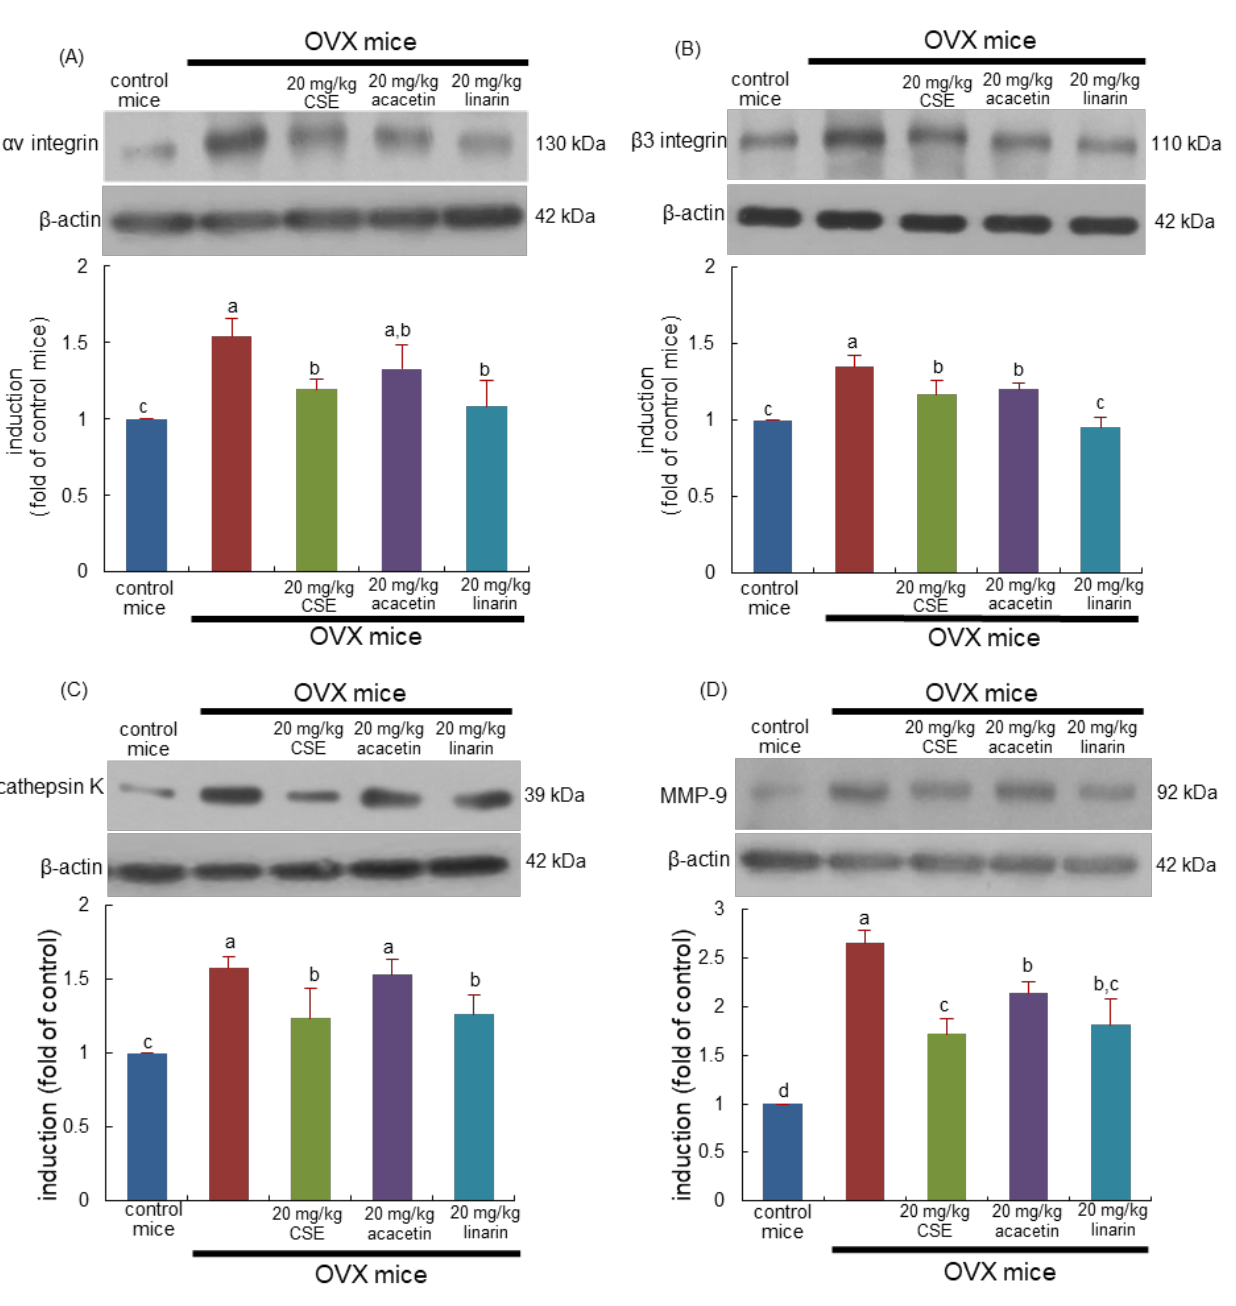
Figure 4. Blockade of induction of α v integrin ( A ), β 3 integrinin ( B ), cathepsin K ( C ), and matrix metalloproteinase (MMP)-9 ( D ) induced by Cirsium setidens water extracts (CSEs) in femoral bone tissue sections of ovariectomized (OVX) mice. OVX mice were orally supplemented with 20 mg/kg CSEs, acacetin, or linarin daily for 8 weeks. Western blot data of bone tissues were obtained using anti- α v integrin, anti- β 3 integrinin, anti-cathepsin K, and anti-MMP-9, and β -actin protein was used as internal control. The bar graphs (mean ± SEM) in the right panels represent quantitative results obtained using a densitometer. Values in bar graphs not sharing a small alphabetical letter are different at p < 0.05.